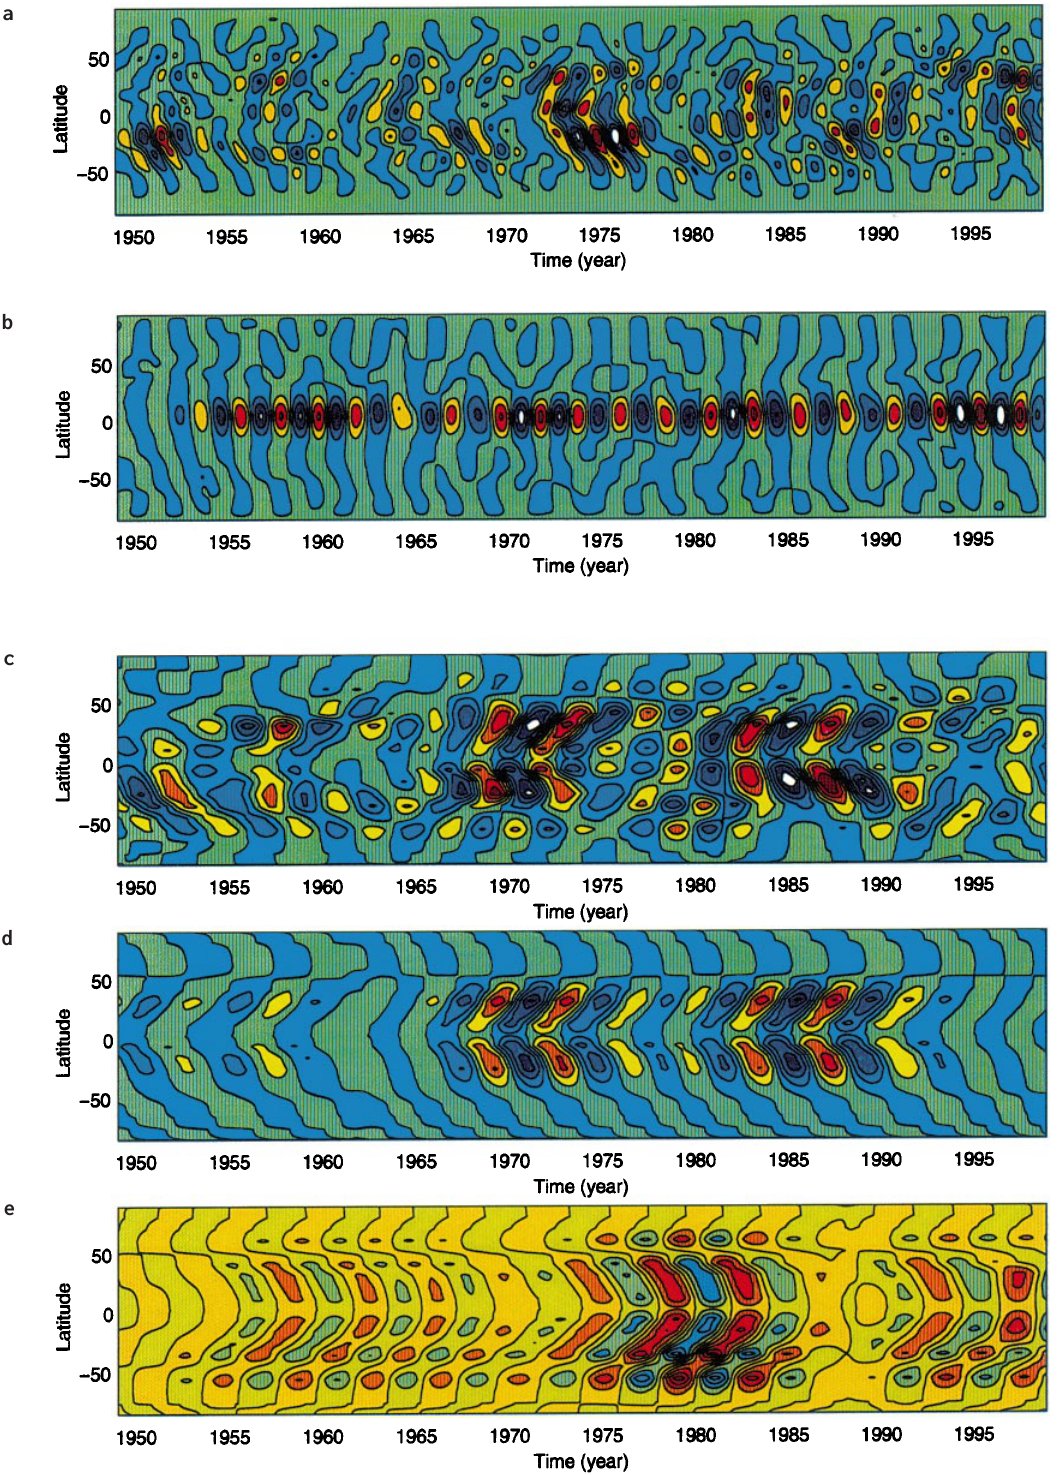
a and b , positive contributions are shown from green to dark red , negative contributions from blue to white , at 0.0025 ms intervals. For c and d , positive contributions are from green to dark red , negative contributions from blue to white , at 0.00125 ms intervals. For e , positive contributions are coloured from orange to red , negative contributions from light green to light blue , at 0.000625 ms intervals. The ordinate is degrees